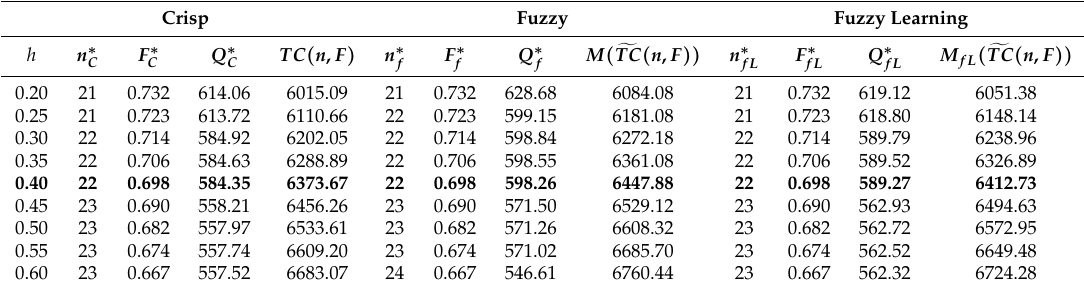
Table 3. Effect of holding cost ( h ) on the crisp, fuzzy, and fuzzy-learning models. Crisp